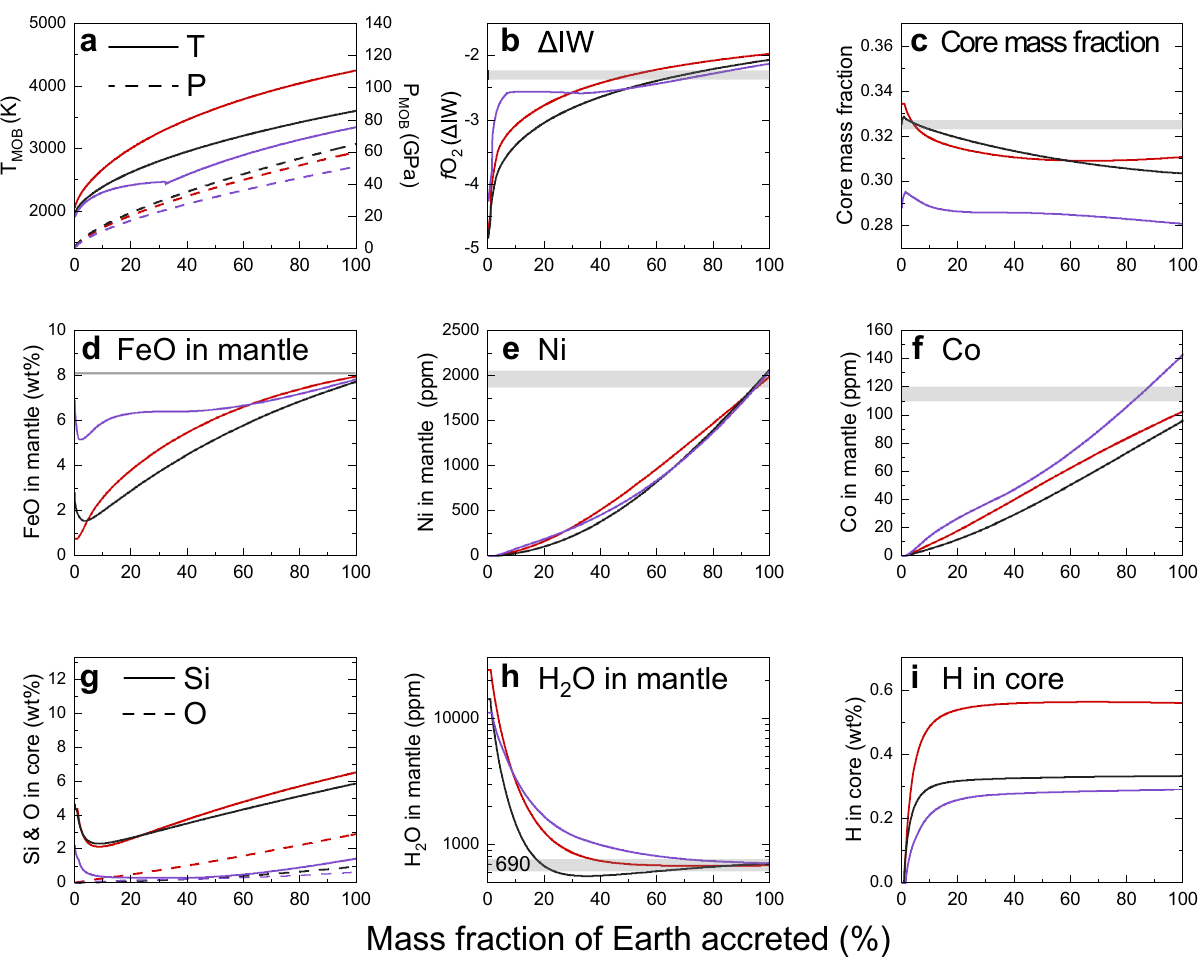
Fig. 4 Evolutions during multi-stage core formation. a P and T and b f O 2 conditions for metal – silicate equilibrium. c Core mass fraction. FeO ( d ), Ni ( e ), Co ( f ), and H 2 O ( h ) in the silicate; and O and Si ( g ) and H ( i ) in the core. Each model, S1 (red), F2 (black), and R3 (purple) in Supplementary Table 4, employed a different combination of P – T path ( a ) and partitioning data 2,3,6,57,63 for elements other than hydrogen (see Supplementary Table 3 for each parameter set). The present Earth values are shown by gray